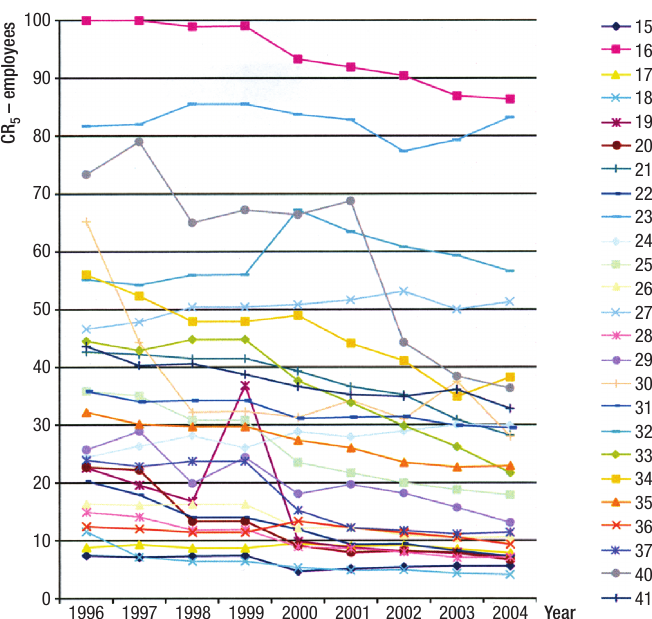
Fig. 4. CR evolution – number of employees during 5